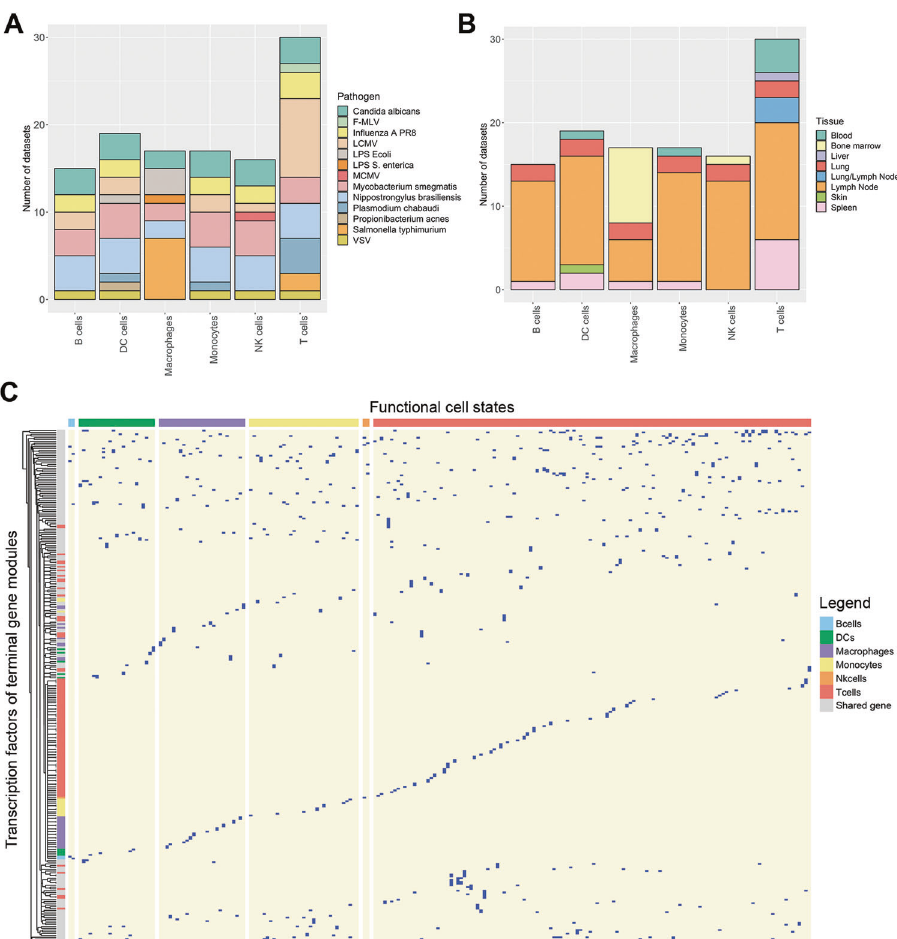
Fig. 2 Overview of the Catalogus Immune Muris content. A, B Composition of the Catalogus Immune Muris. Repartition by immune cell type of the ( A ) 12 pathogens and ( B ) 8 tissues across the 114 datasets. LPS S. enterica and S. typhimurium are considered as the same pathogen. C Binary heatmap displaying the terminal gene modules identi fi ed by FunPart for each functional cell states belonging to one of the six broad immune cell type. Shared genes, colored in gray, correspond to transcription factors found in more than one terminal gene module. Only TFs of terminal gene modules are